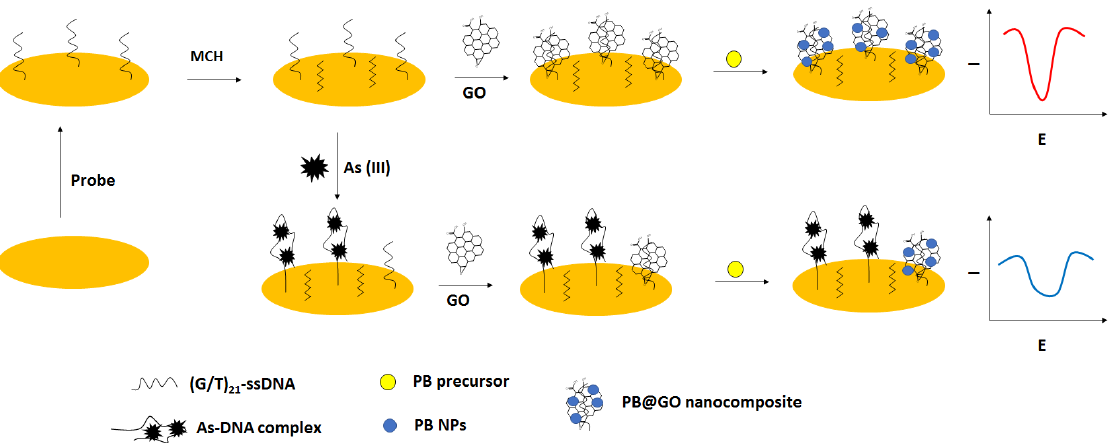
Figure 26. The sensing principle scheme of the electrochemical aptasensor towards arsenic ion based on in situ generation of Prussian blue